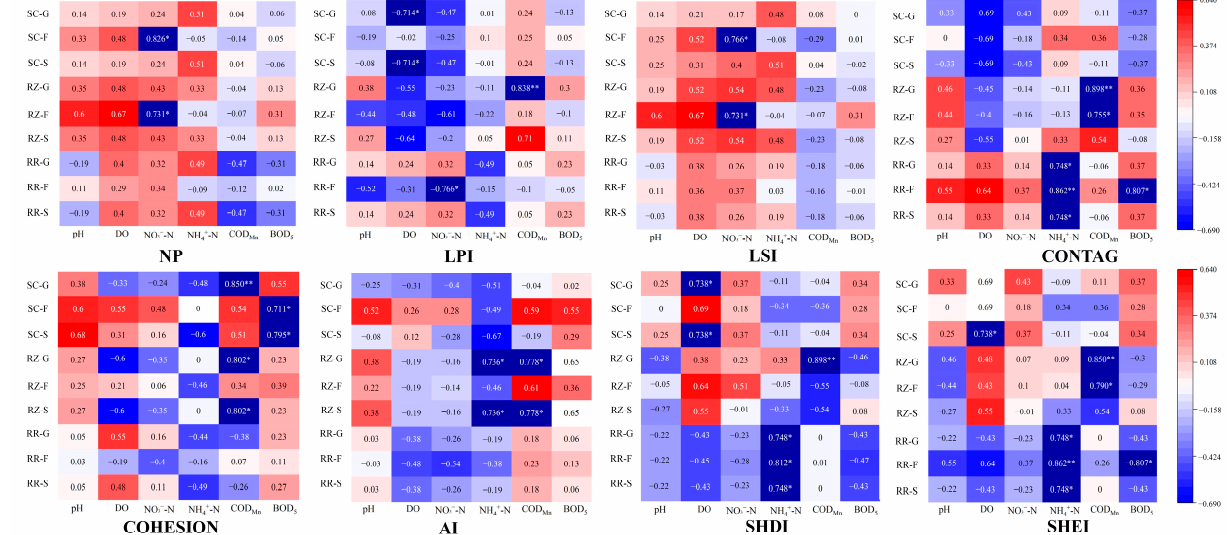
Figure 6. The correlation between landscape indices and RWQ in different spatial and slope scales. Note: “*” means significant difference at p < 0.05; “**” means significant difference at p <